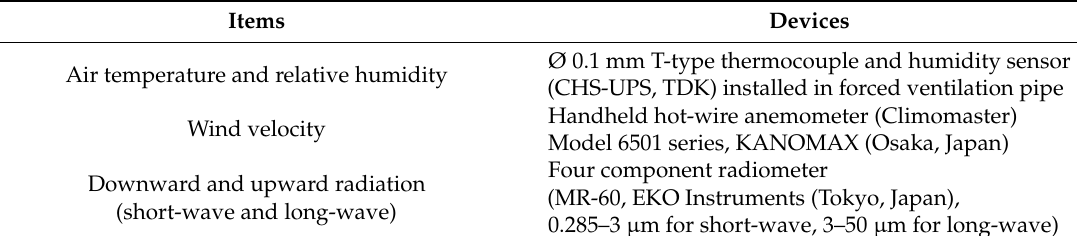
Table 2. Items and devices used for mobile observations.